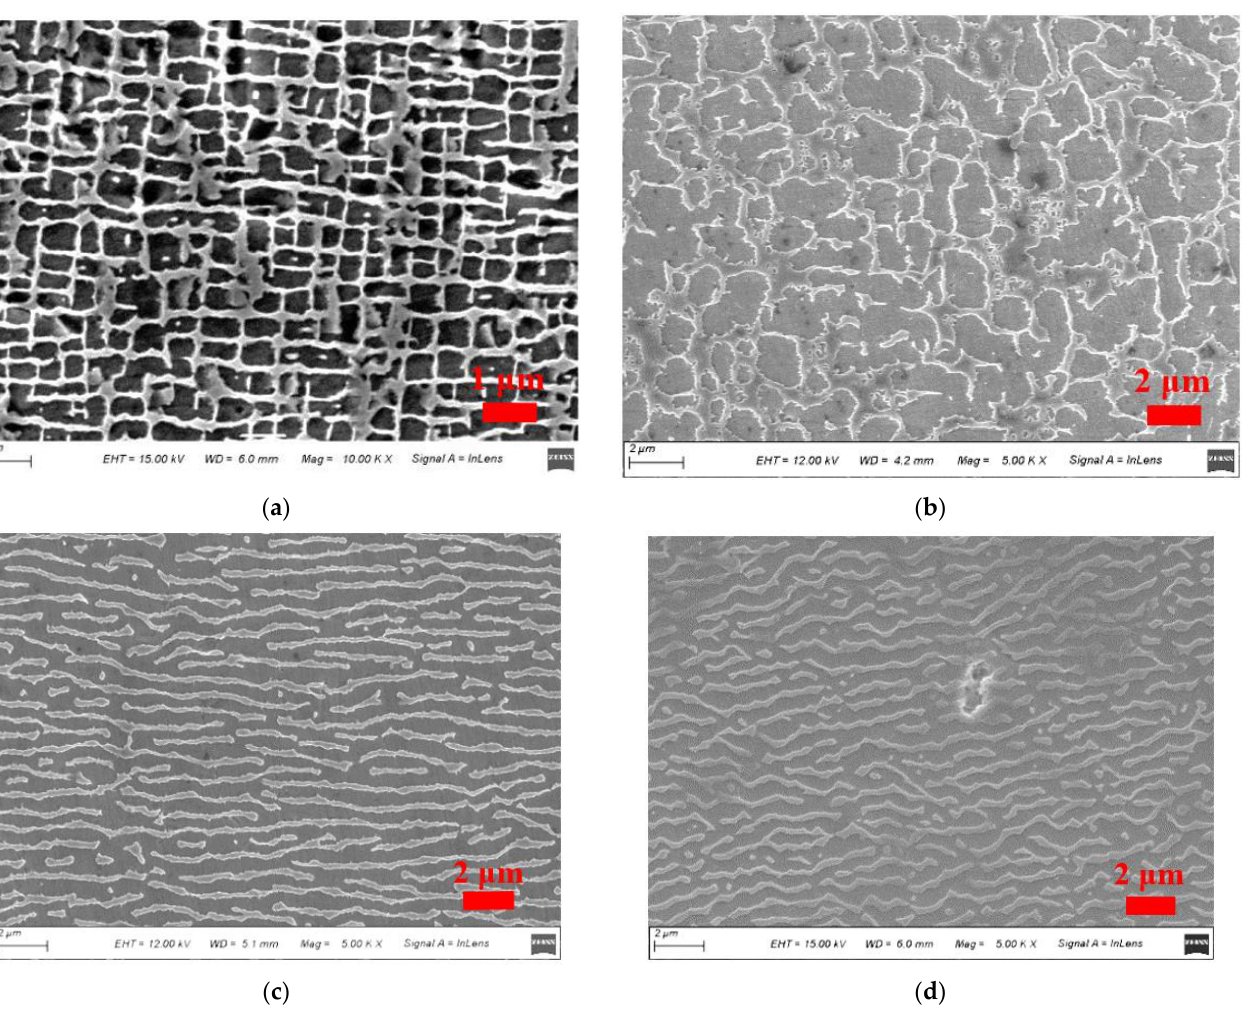
Figure 9. Tensile creep microstructure morphology at 980 °C/300 MPa. ( a ) 30 h, ( b ) 60 h, ( c ) 90 h and ( d ) 125 h.